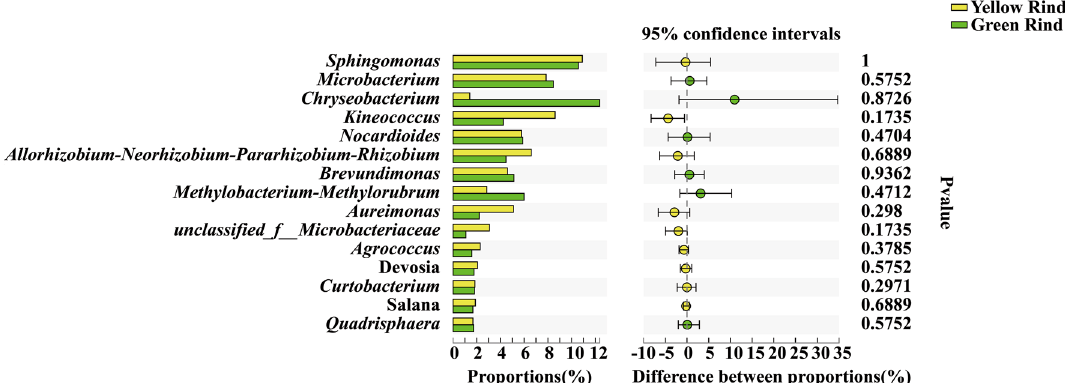
Figure 8. Difference test of endophytic bacteria at genus level between yellow and green rind watermelons. *0.01 < p ≦ 0.05, **0.001 < p ≦ 0.01, *** p ≦ 0.001. (Sequences that could not be classified into any known group were assigned as “unclassified”.)